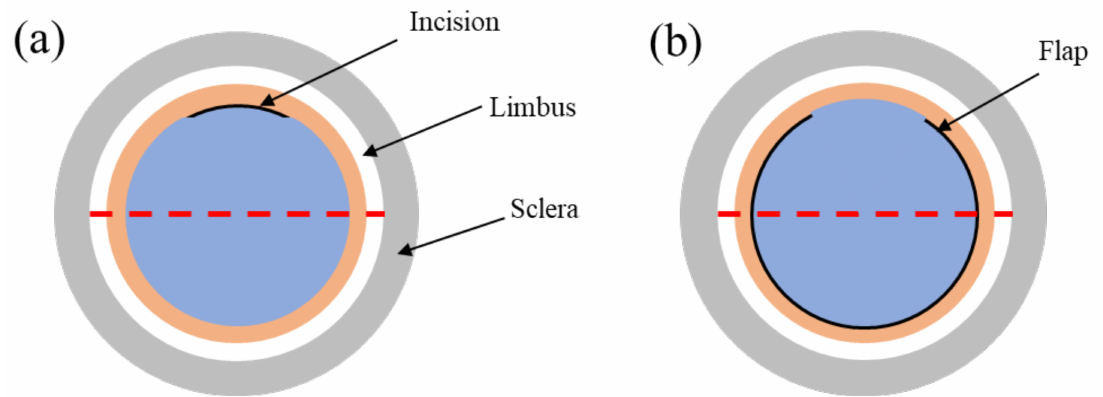
Figure 1. The ARF-OCE experiment protocol of the SMILE and FLEx surgery, ( a ) is the SMILE surgery incision structure, the SMILE procedure preserves most of the anterior corneal stroma by creating a small 2–3 mm incision in the anterior corneal stroma and removing the stromal microcrystalline lens; ( b ) is the FLEx surgery flap structure, the FLEx procedure uses a femtosecond laser to create a corneal flap on the surface of the cornea and then thin the